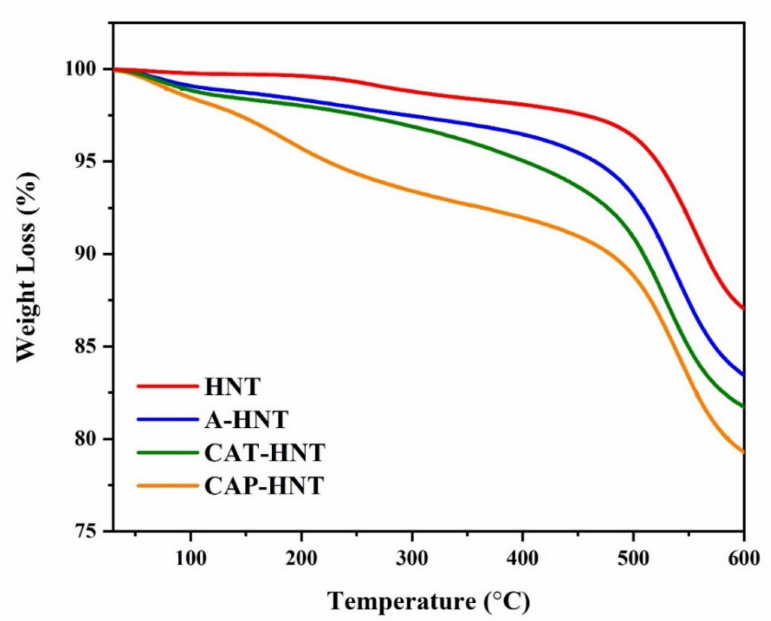
Figure 4. TGA thermograms of pristine HNT and of HNTs surface modified with APTES, CAT, and CAP.